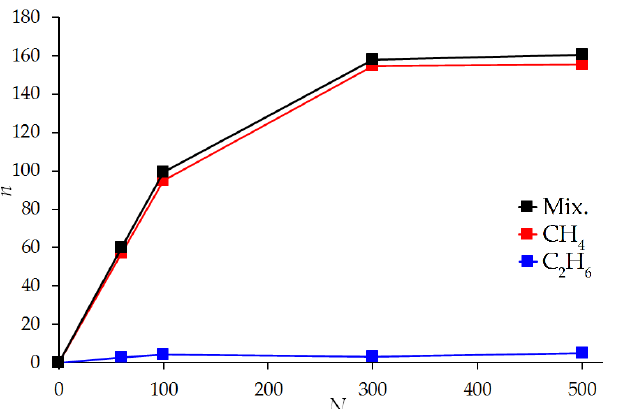
Figure 13. Integral dependence of the number of adsorbed molecules n of methane CH 4 and ethane C 2 H 6 and their total number Mix. on the number of molecules N (ratio of the number of molecules of methane and ethane 95:5) in an array of simulation cells, quantitatively corresponding to the pore size distribution of the ACPK adsorbent. The temperature is 293 K.